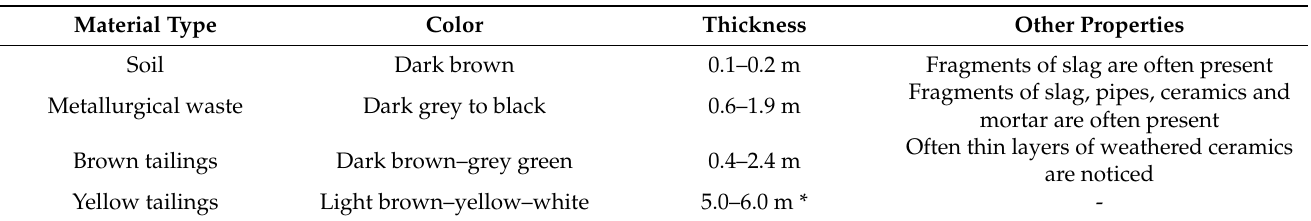
Table 1. Macroscopic description and average thickness of the four types of material present in the drill and pit-holes at the Plombi è res site.